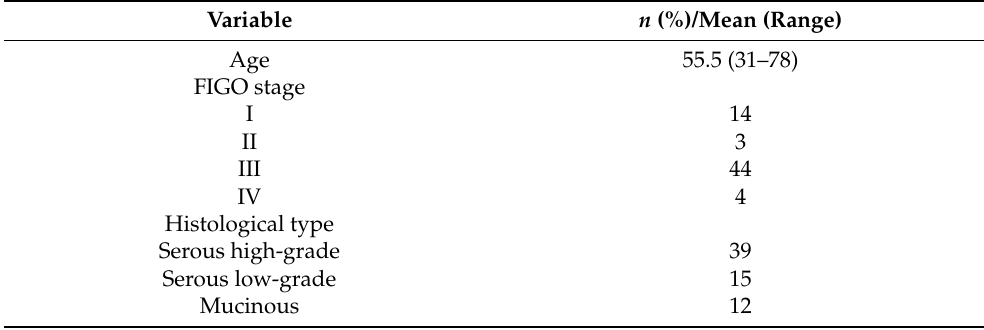
Table 1. Clinicopathological characteristics of 66